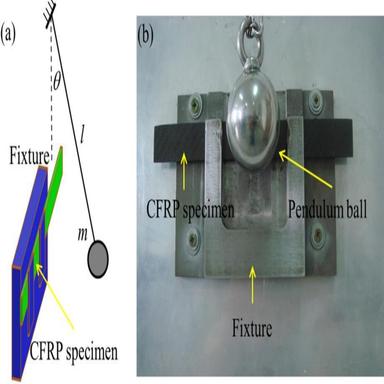
Sketch of (a) pendulum impact device and (b) image of fixture.